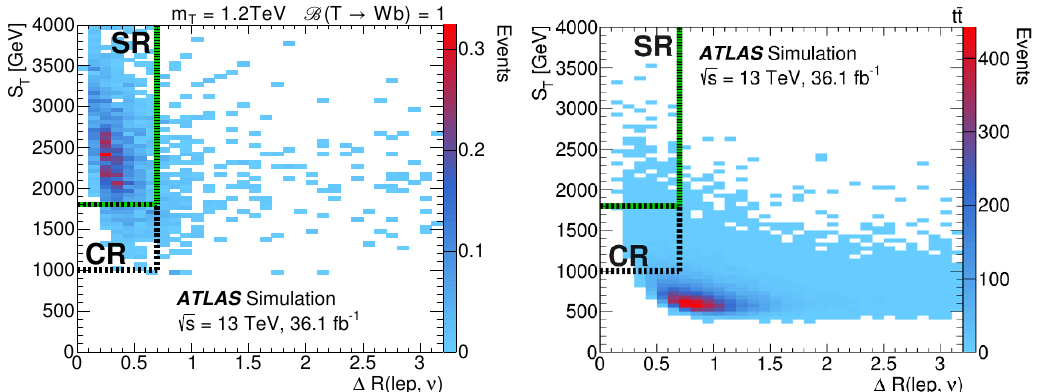
Figure 2 . The signal region (SR) and control region (CR) are shown in a two-dimensional plane of S T and (cid:1) R (lep ; (cid:23) ), overlaying the expected signal distribution for B ( T ! Wb ) = 1 and a mass of 1.2 TeV (left) and overlaying the distribution of the dominant t (cid:22) t background (right). (cid:1) R (lep ; (cid:23) ) < 0 : 7, arising from a boosted leptonically decaying W boson. In addition, S